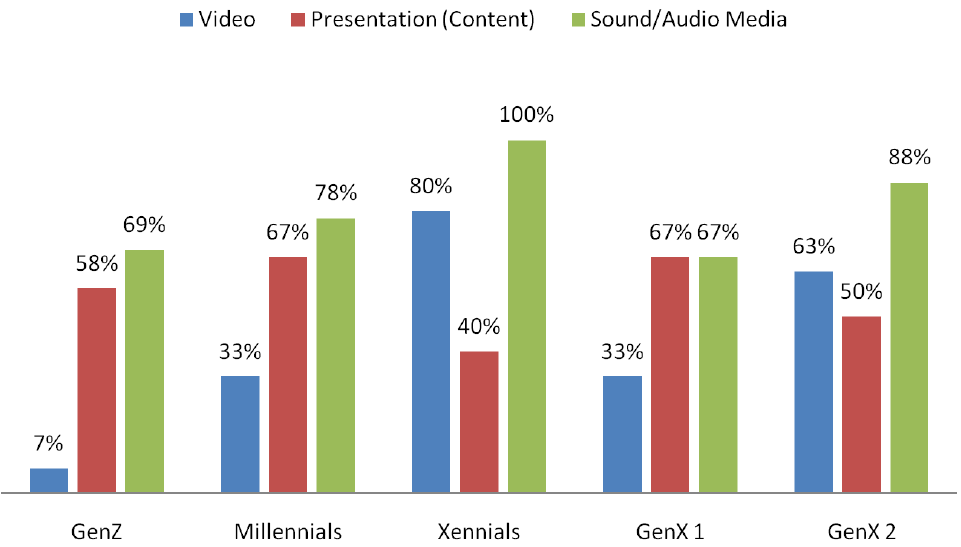
Figure 2. Grouped and adjusted qualitative data as quantitative data from the second part of the evaluation form in three categories of budding journalists based in age groups (genealogical cohorts).